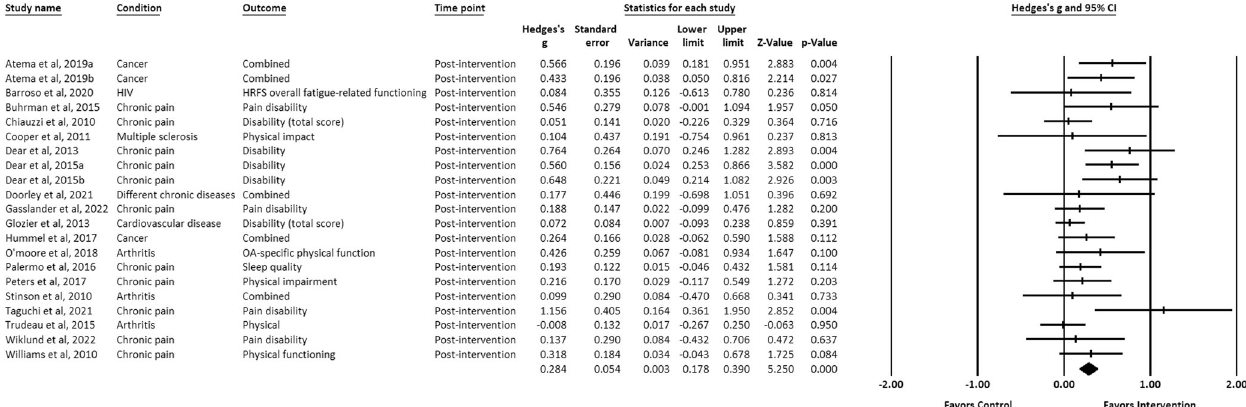
Fig. 12 Forest plot for effect sizes of IM-CBT on functional impairment at post-intervention. Note. “ Combined ” (under the column “ Outcome ” ) indicates that multiple outcomes on functional impairment were retrieved and averaged from the same